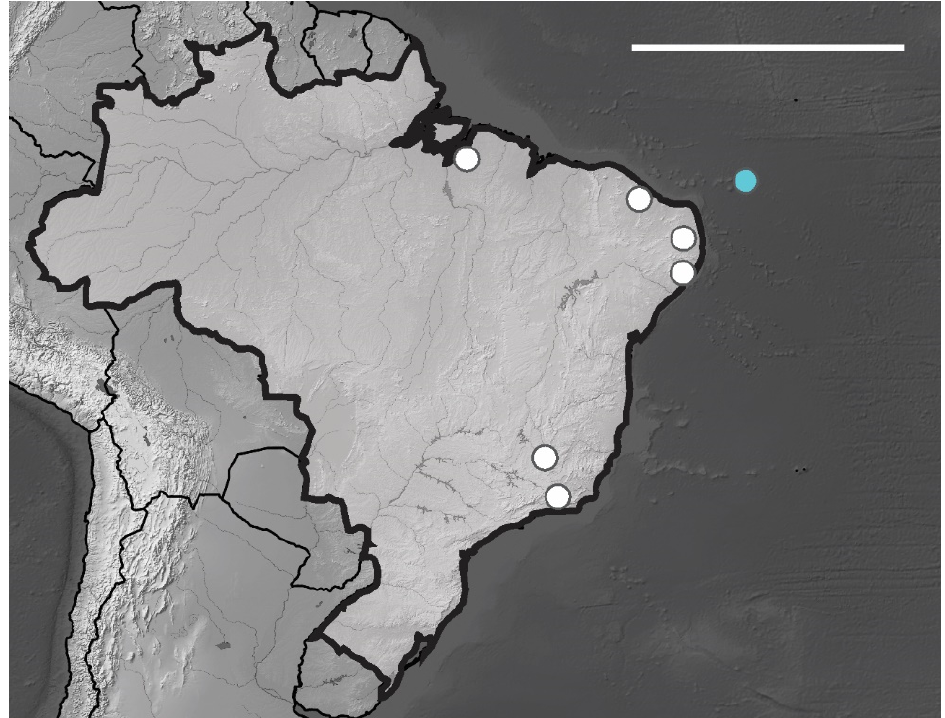
Figure 12. Distribution map for Arlesia albipes (Folsom, 1927) records in Brazil. Blue circle, Fernando de Noronha; white circle, Brazilian states. Scale bar: 3000 km. Table 4. Morphological characters of Arlesia Handschin, 1942 species recorded from Brazil. BD—body length in mm; AP—apical bulb vesicles; SF—sensory formula; MT—mandibular teeth; TL—type locality.